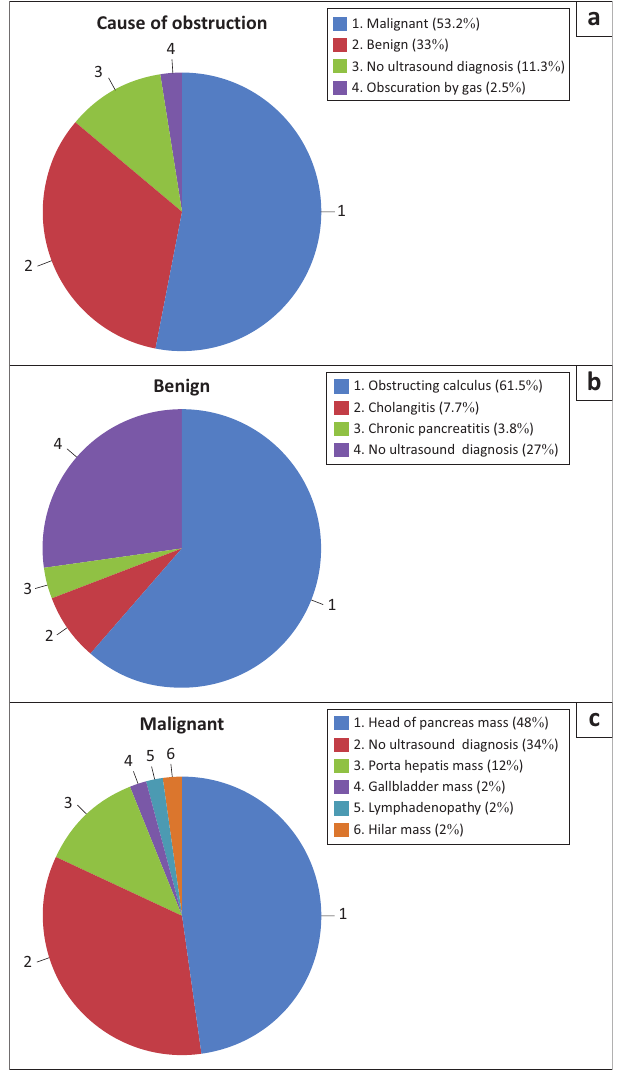
FIGURE 1: The spectrum of suggested causes of biliary obstruction in both benign and malignant groups: (a) cause of obstruction; (b) benign and (c) malignant.